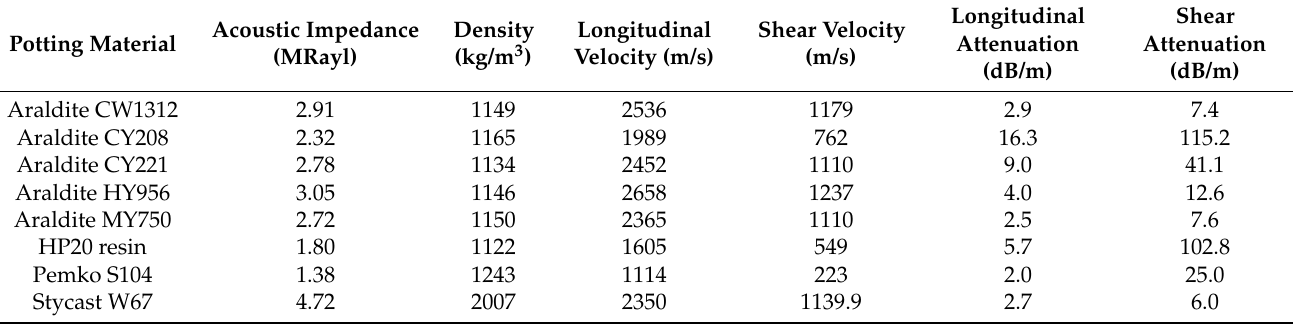
Figure 4. FEA model of the potted cymbal array.